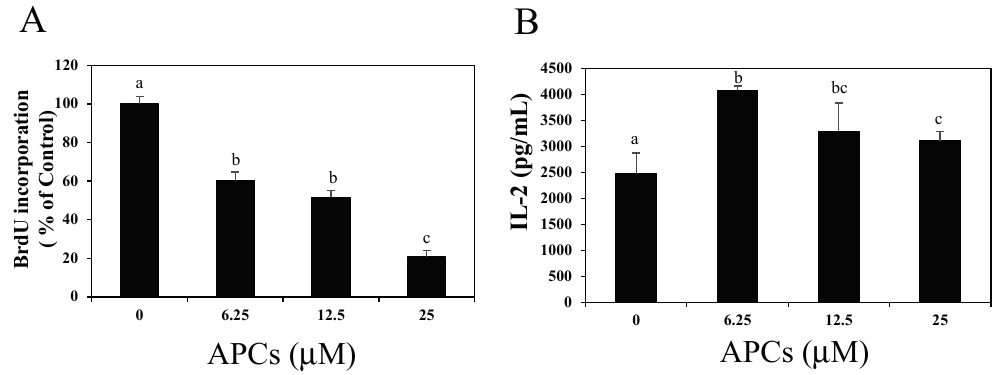
Figure 2. Dose-dependent effects of apple procyanidins (APCs) on cell proliferation ( A ) and interleukin (IL)-2 production ( B ) of activated CD4 + T cells. Splenic CD4 + T cells were stimulated with an anti-CD3 ε monoclonal antibody in the presence of APCs (0–25 μ M). ( A ) Cell proliferation was evaluated by measuring the incorporation of BrdU after 72 h of stimulation. The group without APCs treatment (0 μ M of APCs) was indicated as